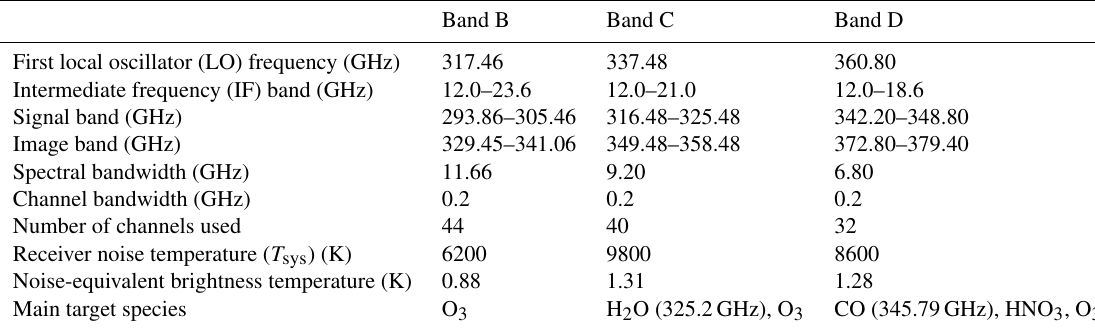
Table 1. Frequency coverage and spectral performance of the three MARSCHALS spectral bands. Band B Band C Band D First local oscillator (LO) frequency (GHz) 317.46 337.48 Intermediate frequency (IF) band (GHz) Signal band (GHz) Image band (GHz) Spectral bandwidth (GHz) Channel bandwidth (GHz) 0.2 0.2 0.2 Number of channels used 44 Receiver noise temperature ( T sys ) (K) 6200 9800 8600 Noise-equivalent brightness temperature (K) 0.88 1.31 1.28 Main target species O 3 H 2 O (325.2GHz), O 3 CO (345.79GHz), HNO 3 , O